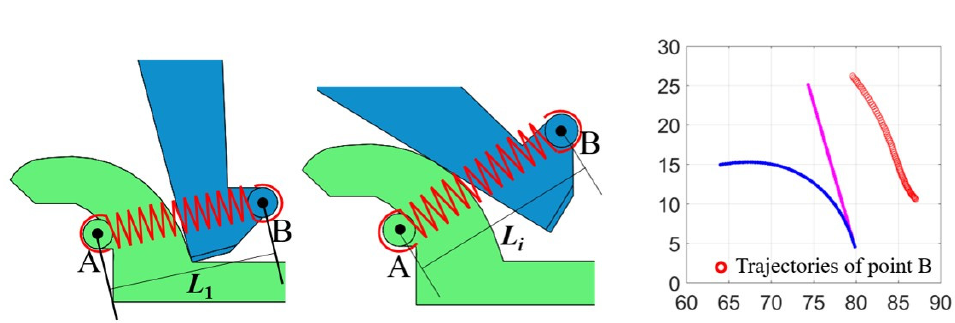
Figure 12. Trajectory of the spring mounting point.